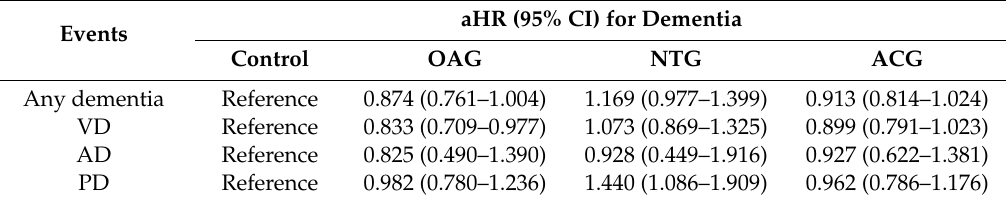
Table 5. Correlation between type of glaucoma and the development of dementia